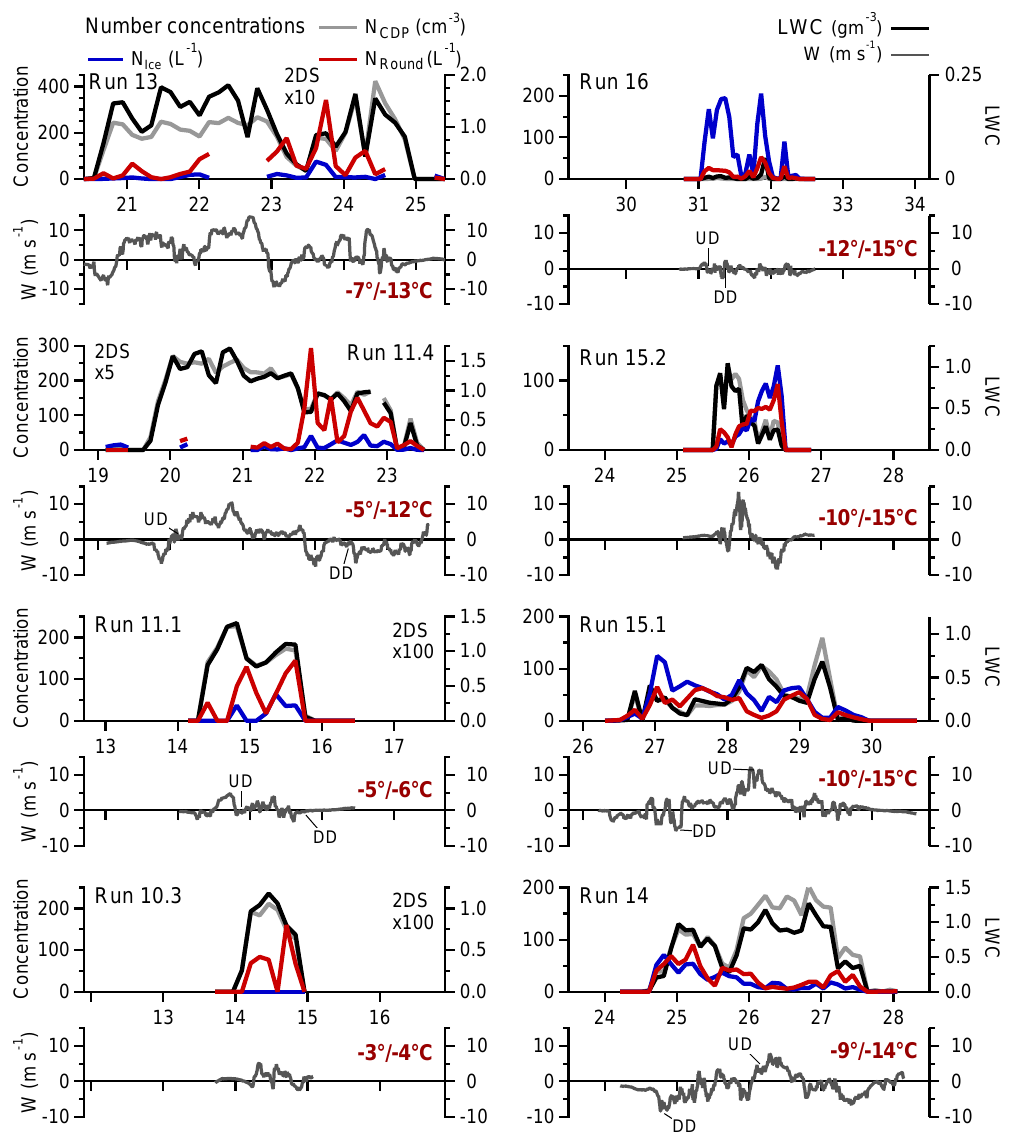
Figure 7. In situ data measured aboard the BAe-146 during a series of runs following an initially isolated turret as it moved downwind, growing in height and glaciating as it spread to join the preceding line. The x axis is the same as in Figs. 5 and 6. The colours of the traces shown are the same as in Fig. 5. For clarity, the 2DS traces ( N Ice and N Round ) in runs 10.3–13 are multiplied by factors listed in the corresponding panel. The text in red shows the run temperature and the cloud-top temperature. Further information for each run are listed in Table 2. For reference, concentrations during run 16 would have been recorded 17% lower than those during run 10.3 due to the change in temperature and pressure with altitude. The regions marked “UD” and “DD” show where the updraft and downdraft images in Figs. 8 and 9 are taken